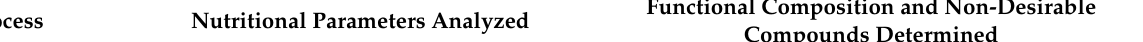
Table 1. Origin of the carob pulp, and the elaboration process of carob products (syrups, creams, baked goods, pasta, dairy products and beverages). Nutritional and functional characteristics studied in the different